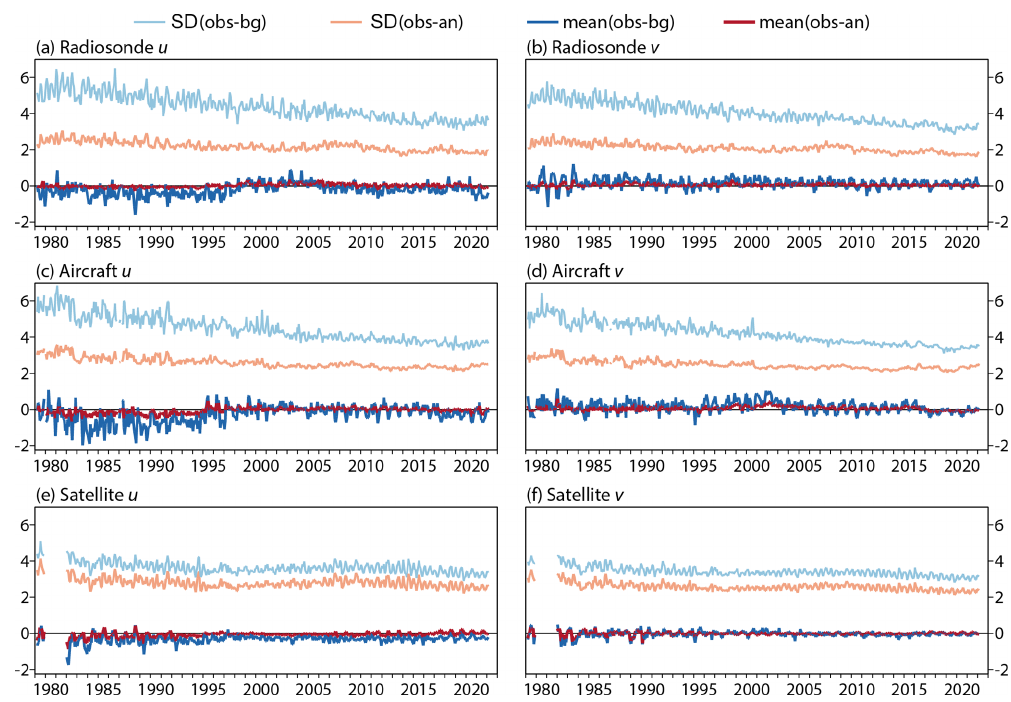
Figure 13. Monthly means and standard deviations of observation minus background (dark and light blue) and observation minus analysis (red and orange) departures (ms − 1 ) for the 175 to 225hPa layer over the region from 10 ◦ S to 10 ◦ N and 90 ◦ W to 150 ◦ E, from March 1979 to February 2022, for zonal ( u ) and meridional ( v ) wind components from (a, b) radiosondes, (c, d) aircraft and (e, f) satellite